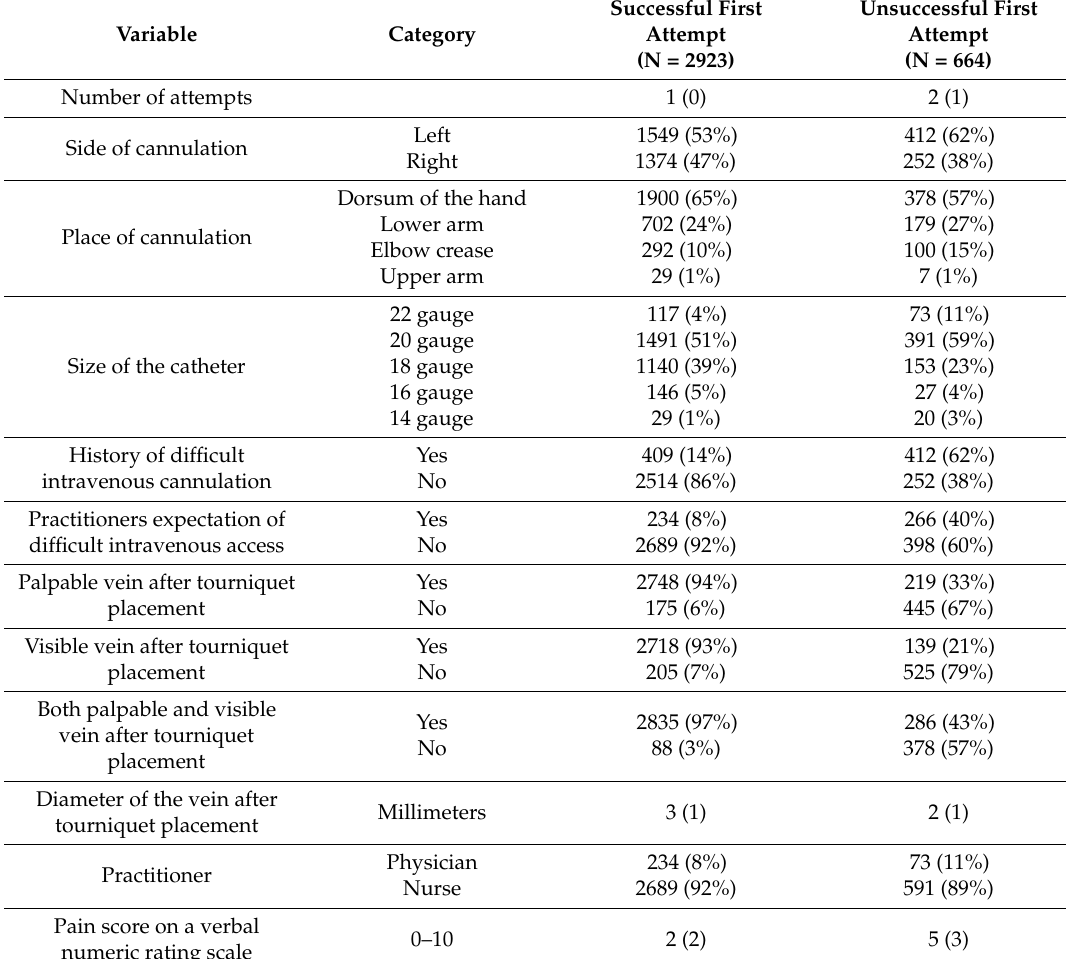
Table 2. Data representing the procedure of peripheral intravenous